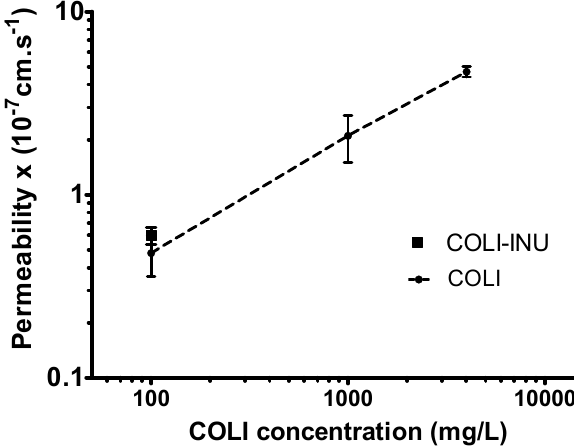
Figure 5. Apical-to-basal COLI apparent permeability across a Calu-3 cell epithelium model measured after 6 h of incubation of the apical side monolayer in the presence of different COLI concentrations (100, 1000, and 4000 mg/L for pure COLI and 100 mg/L for INU-COLI particle).